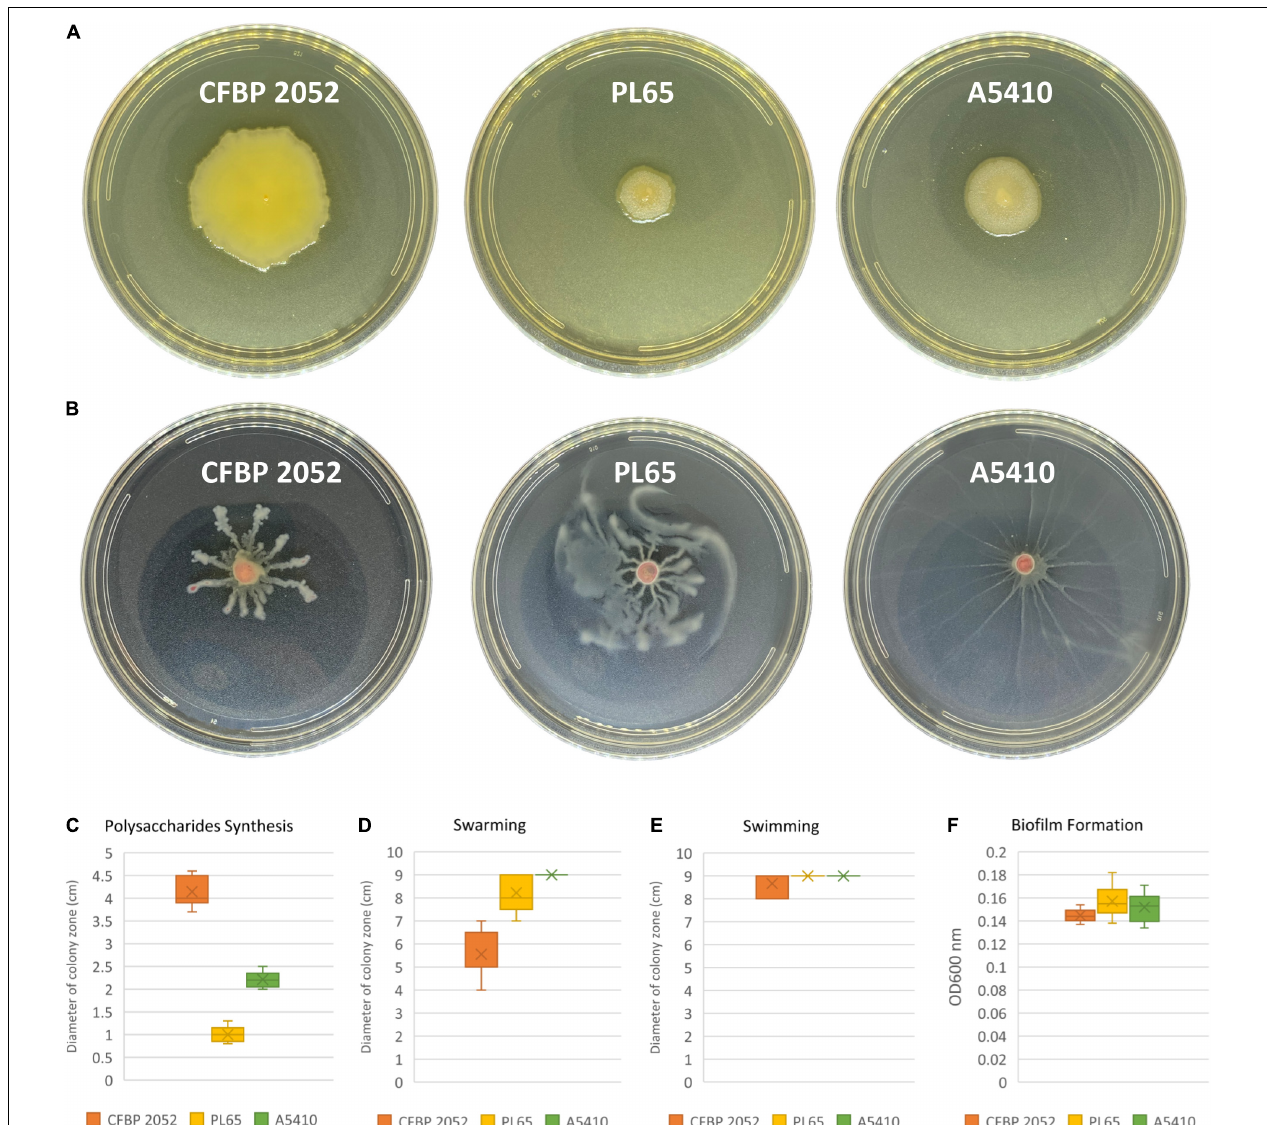
FIGURE 11 | Exopolysaccharide production and motility of three D. zeae strains. (A) Exopolysaccharide [extracellular polysaccharide (EPS)] production of cells grown in Super Optimal Broth (SOB) medium of three D. zeae strains, and the colony diameter measured 24 h later; (B) swarming capacity of three D. zeae strains was observed in semi-solid medium, after 24 h at 28 ◦ C; (C) production of exopolysaccharides; (D) capability of swarming; (E) capability of swimming; and (F) ability of biofilm